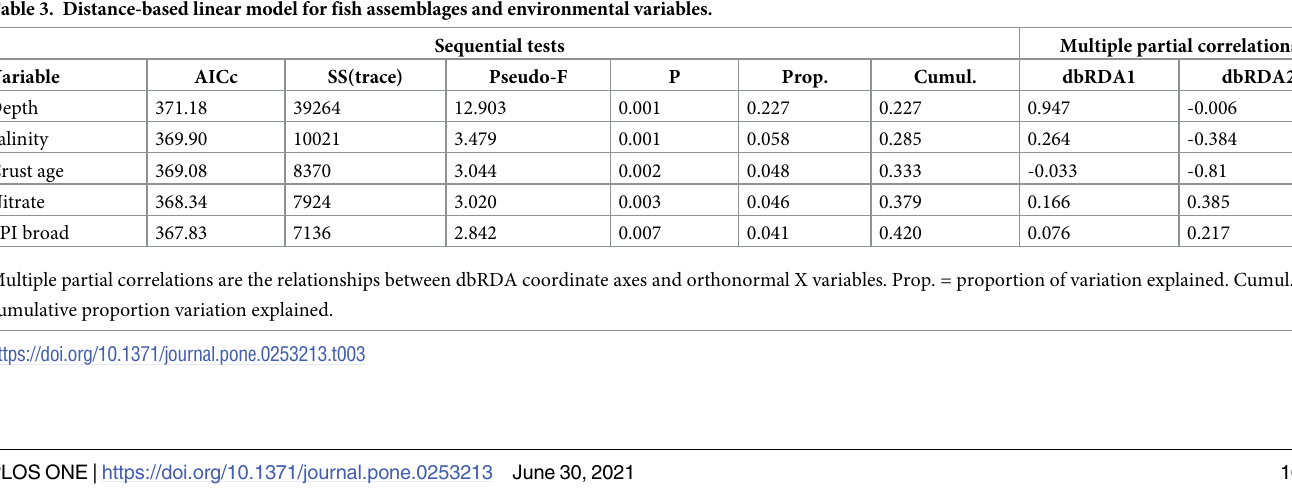
Table 3. Distance-based linear model for fish assemblages and environmental variables.